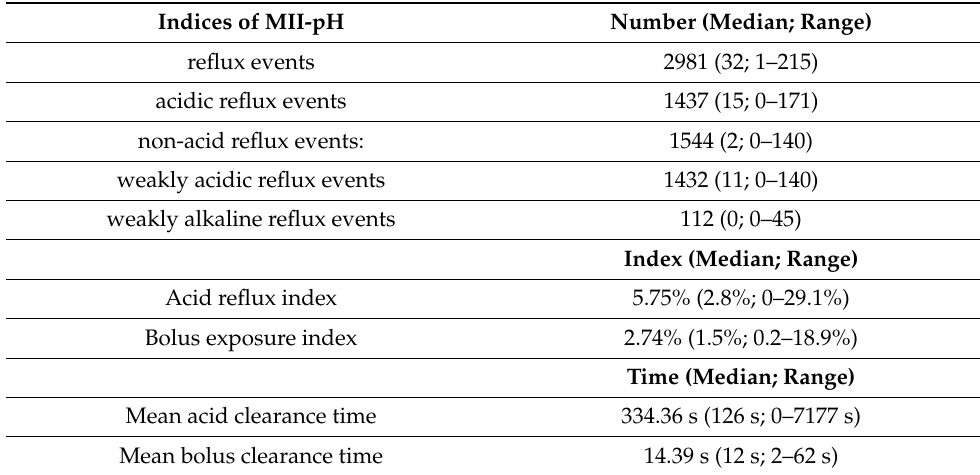
Table 2. GOR parameters determined by MII-pH.